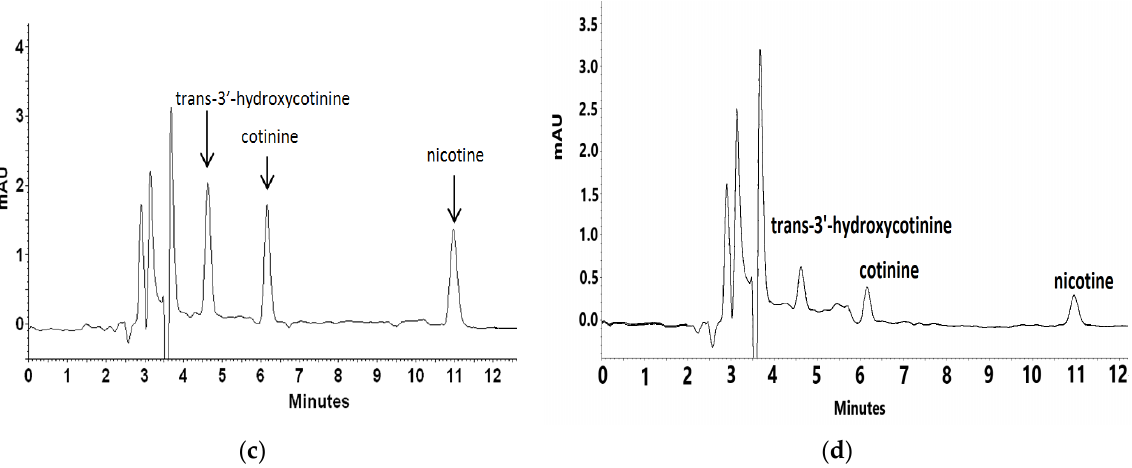
Figure 4. Representative chromatograms of blank plasma sample ( a ) and plasma spiked with trans-3 ′ -hydroxycotinine, cotinine, nicotine standards at a concentration of 1000 ng L − 1 ( b ), 500 ng L − 1 ( c ), and 100 ng L − 1 ( d ). Table 2. The recoveries of trans -3 (cid:48) -hydroxycotinine, cotinine, nicotine from the artificial plasma samples with intra- and inter-day precision.